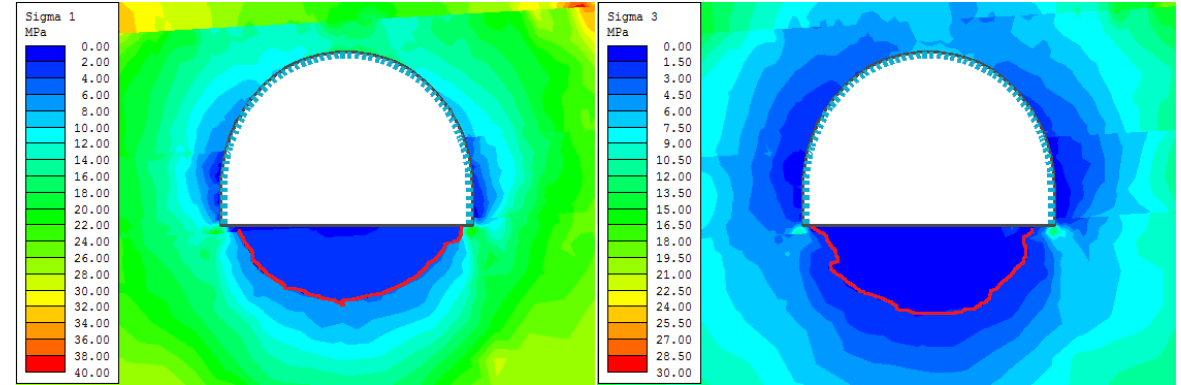
Figure 29. The extent of the failure zone beneath the floor of roadway F-33 — stage 5.